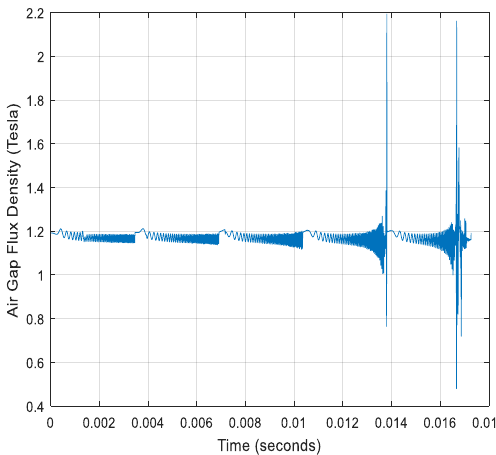
Figure 3. Air gap flux density in time domain (healthy machine).